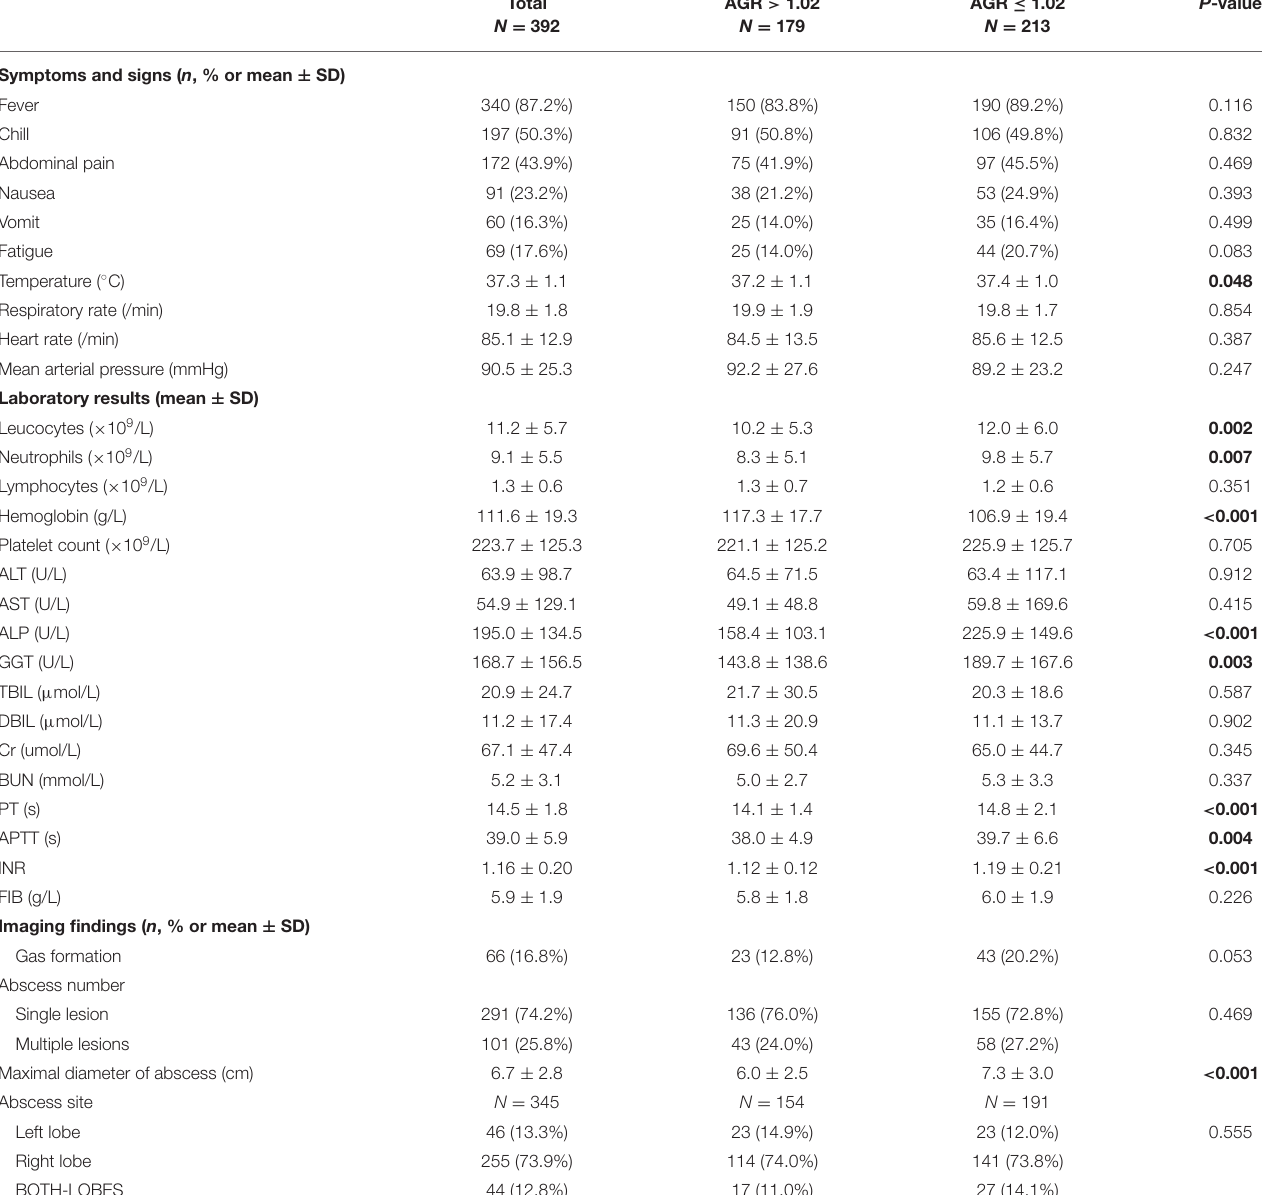
TABLE 2 | Clinical features, laboratory results, and imaging